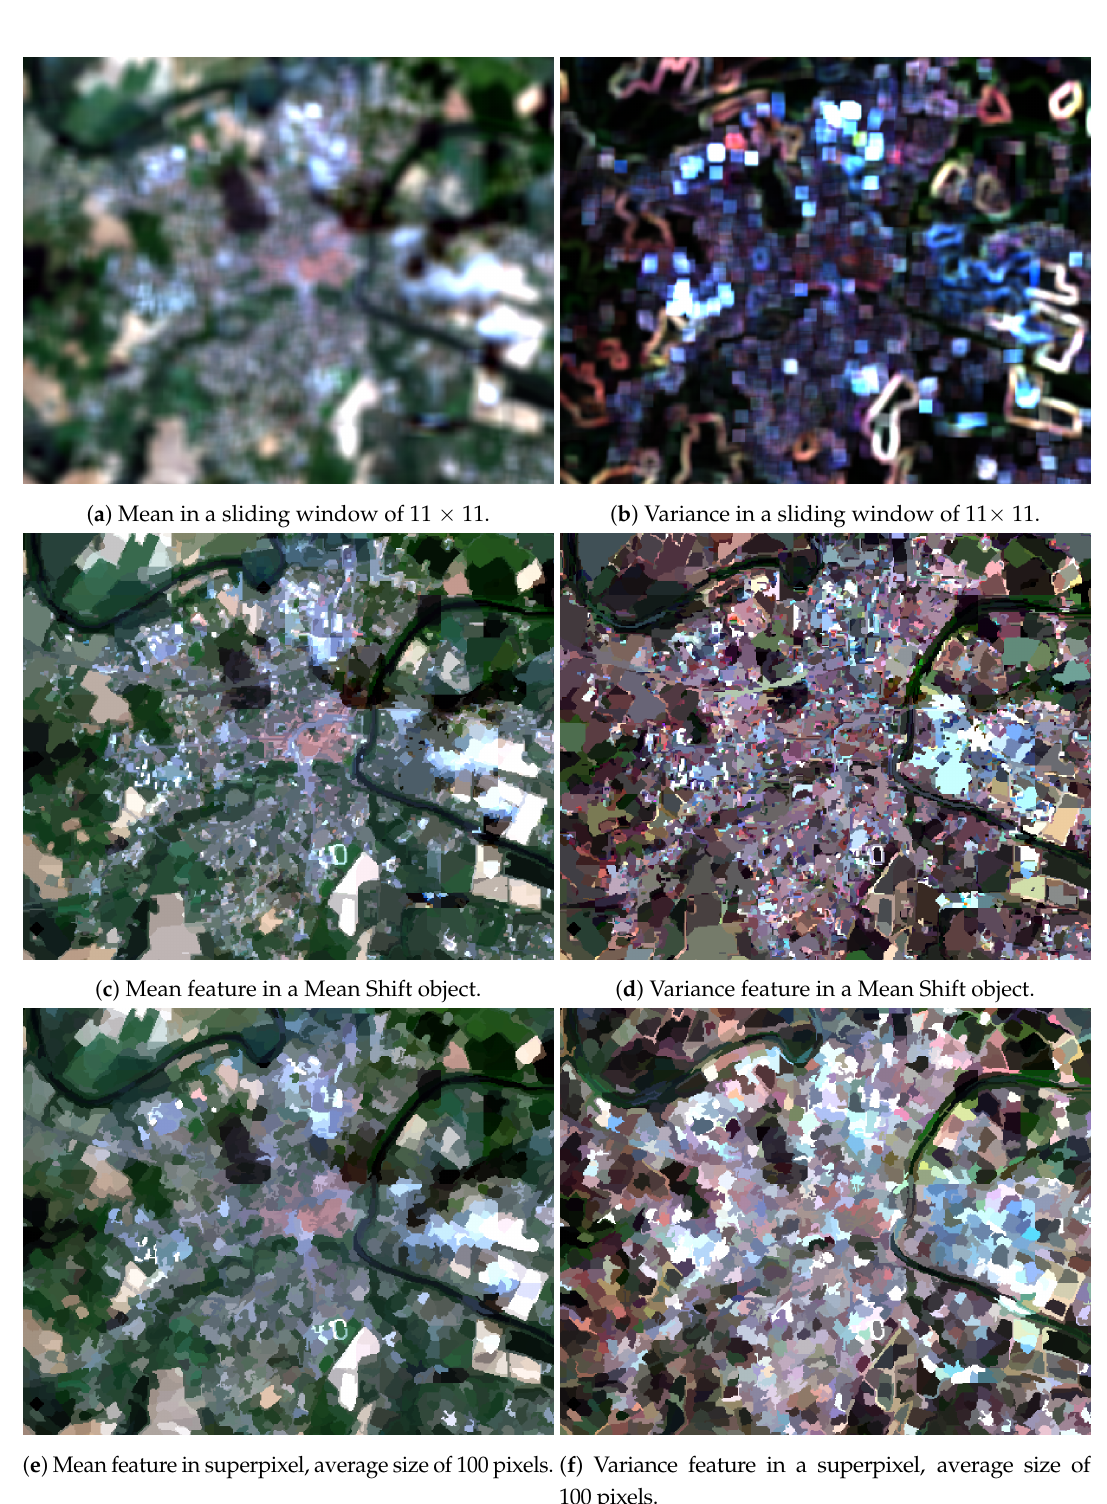
Figure 9. Example images of the mean and variance features on the RGB bands of the first date, calculated in the three spatial support